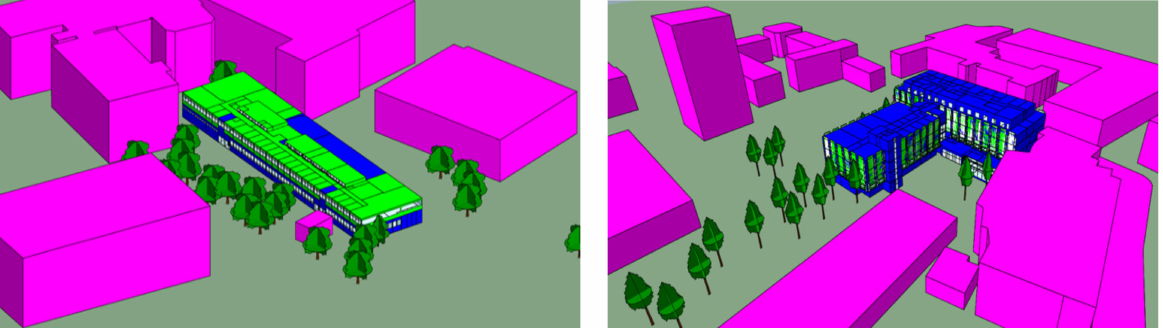
Figure 3. Building simulation IESVE models of John Laing and Richard